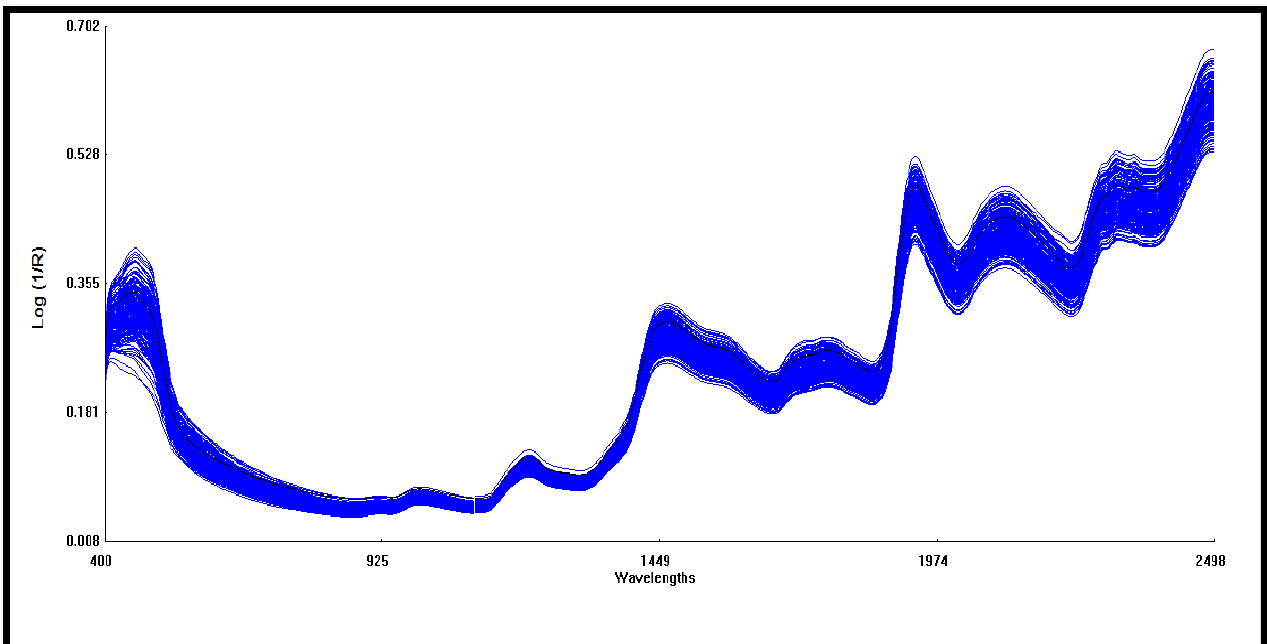
Figure 1. A typical average visible to the near-infrared (400–2500 nm) spectrum illustrates peaks of the calibration data set. The near infrared range (800–2400 nm) was used for the multivariate analysis.